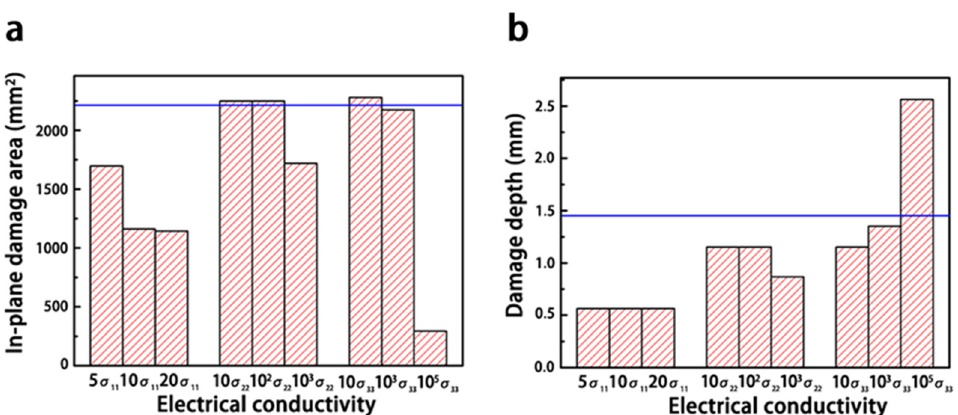
Figure 12. Influence of the electrical conductivity on the degree of lightning damage: ( a ) in-plane damages with different electrical conductivities; ( b ) in-depth damages with different electrical conductivities. The number in front of σ represents the increase in the conductivity of the composite, and the blue line represents the degree of damage in the original composite.